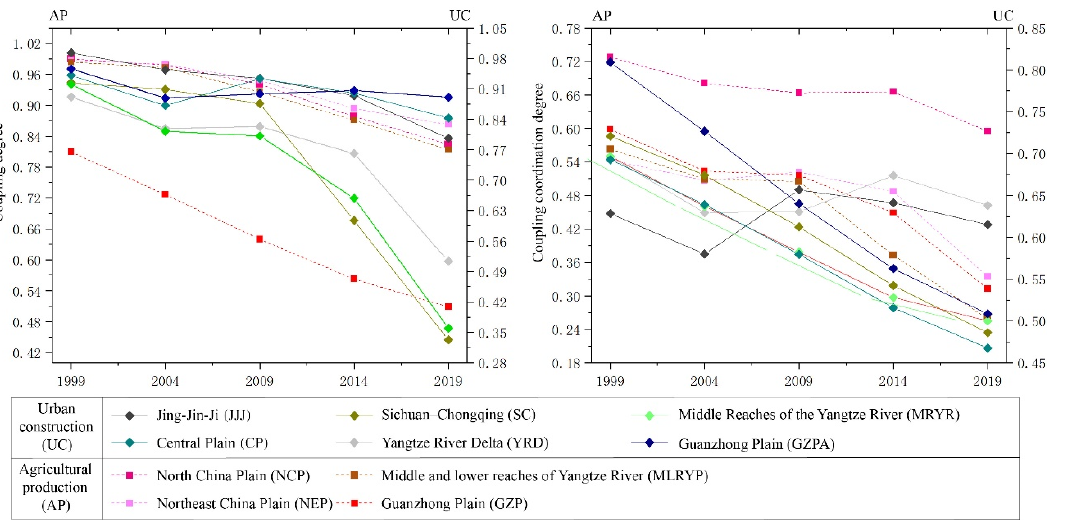
Figure 7. Coupling and coordination changes of territorial space utilization efficiency and carbon emissions intensity from the regional perspective.